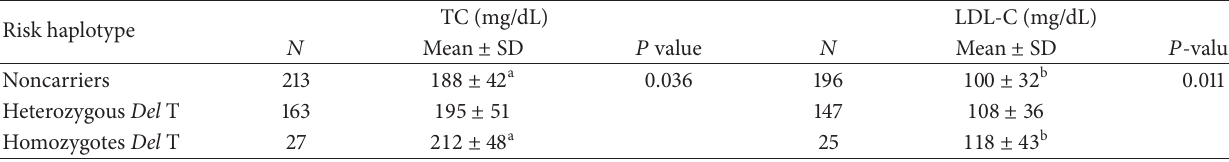
Table 4: Effect of APOB Del T haplotype in total cholesterol and